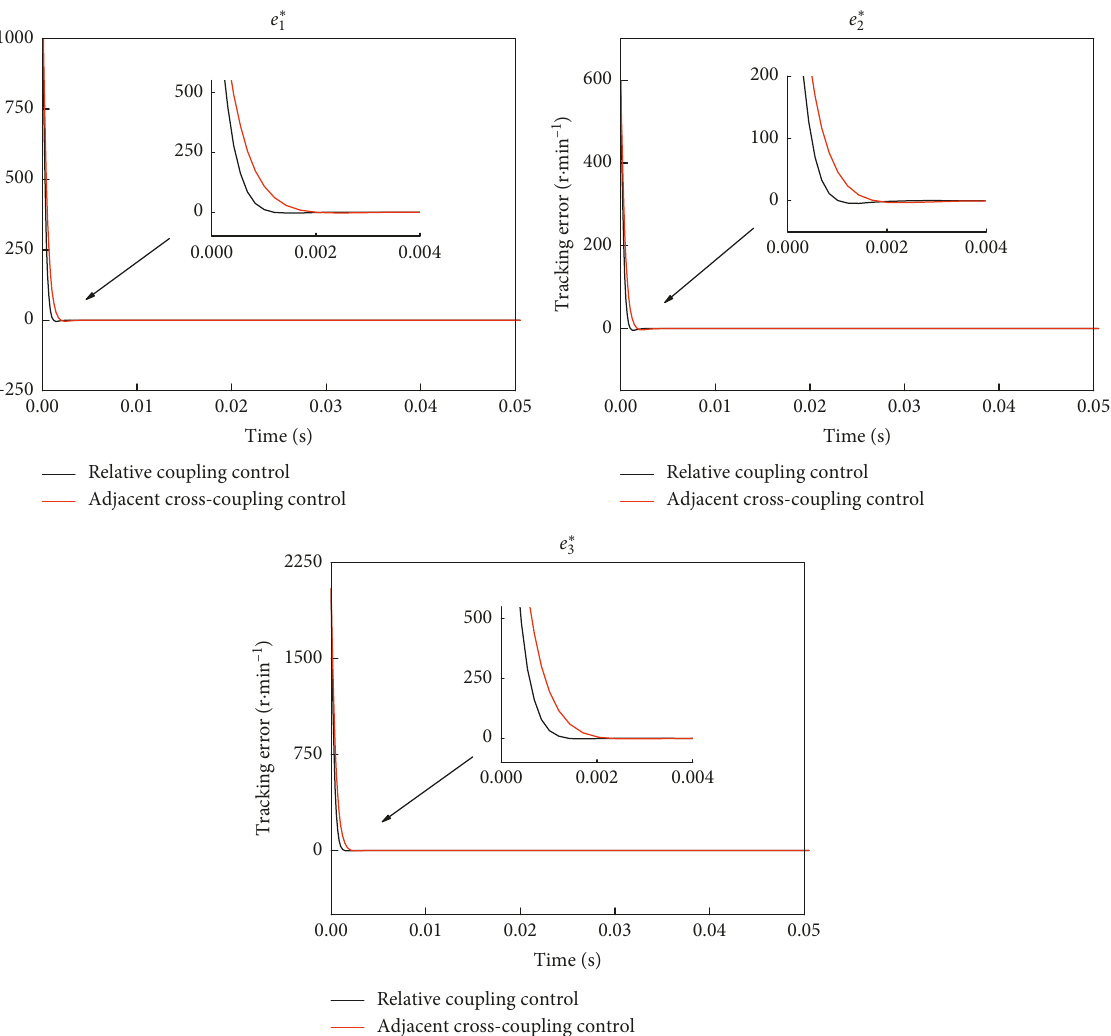
Figure 12: The velocity tracking error of all servos under